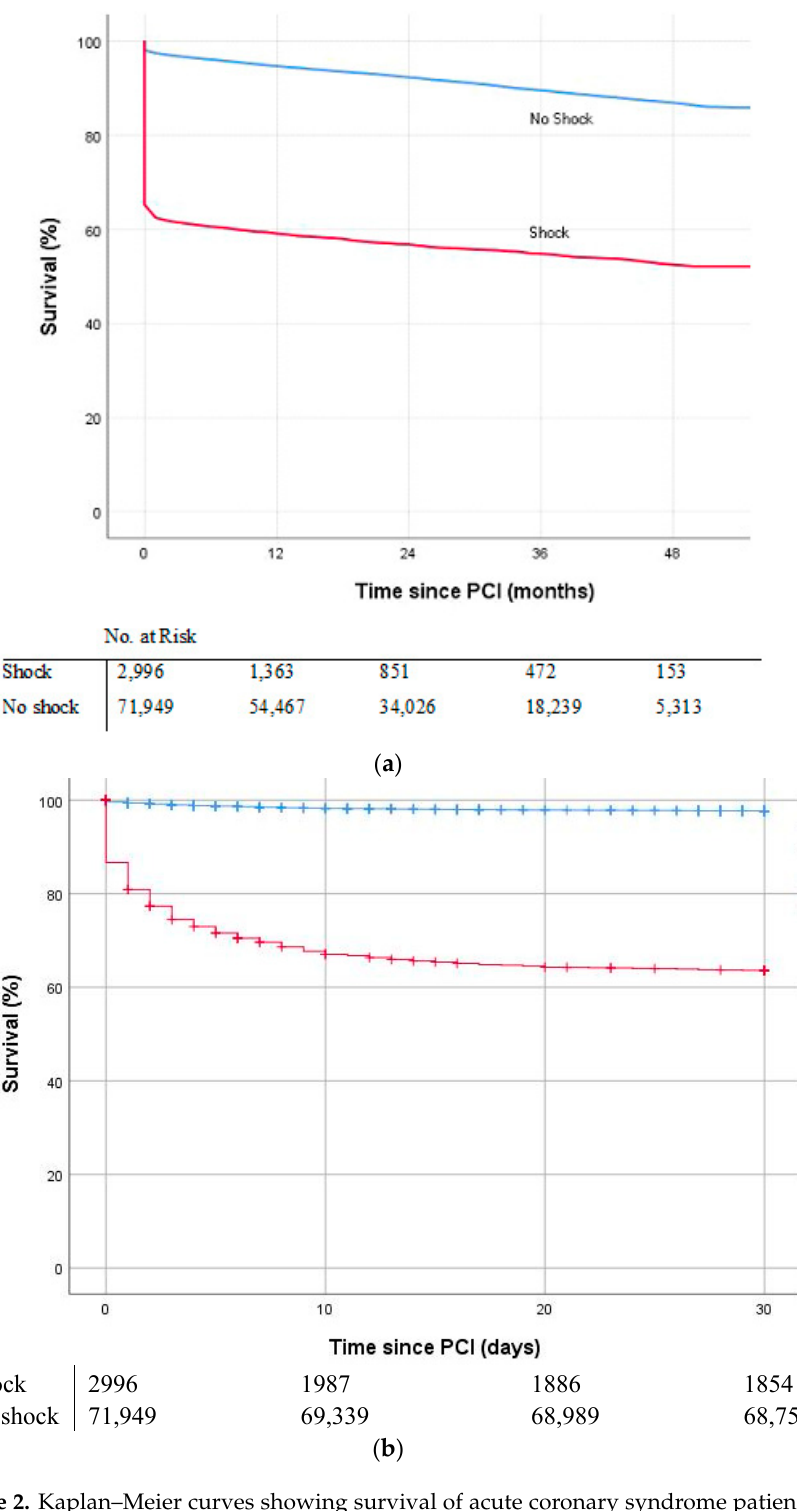
Figure 2. Kaplan–Meier curves showing survival of acute coronary syndrome patients treated by percutaneous coronary intervention with and without cardiogenic shock at admission. ( a ) Over the 4-year study period, ( b ) within 30-days.